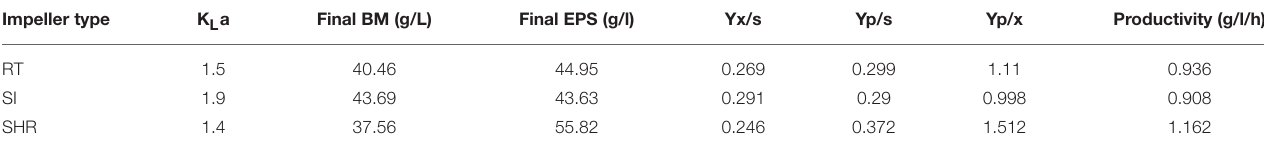
TABLE 2 | Fermentation kinetics of pullulan by Aureobasidium pullulans RBF 4A3 with different impeller. Impeller type